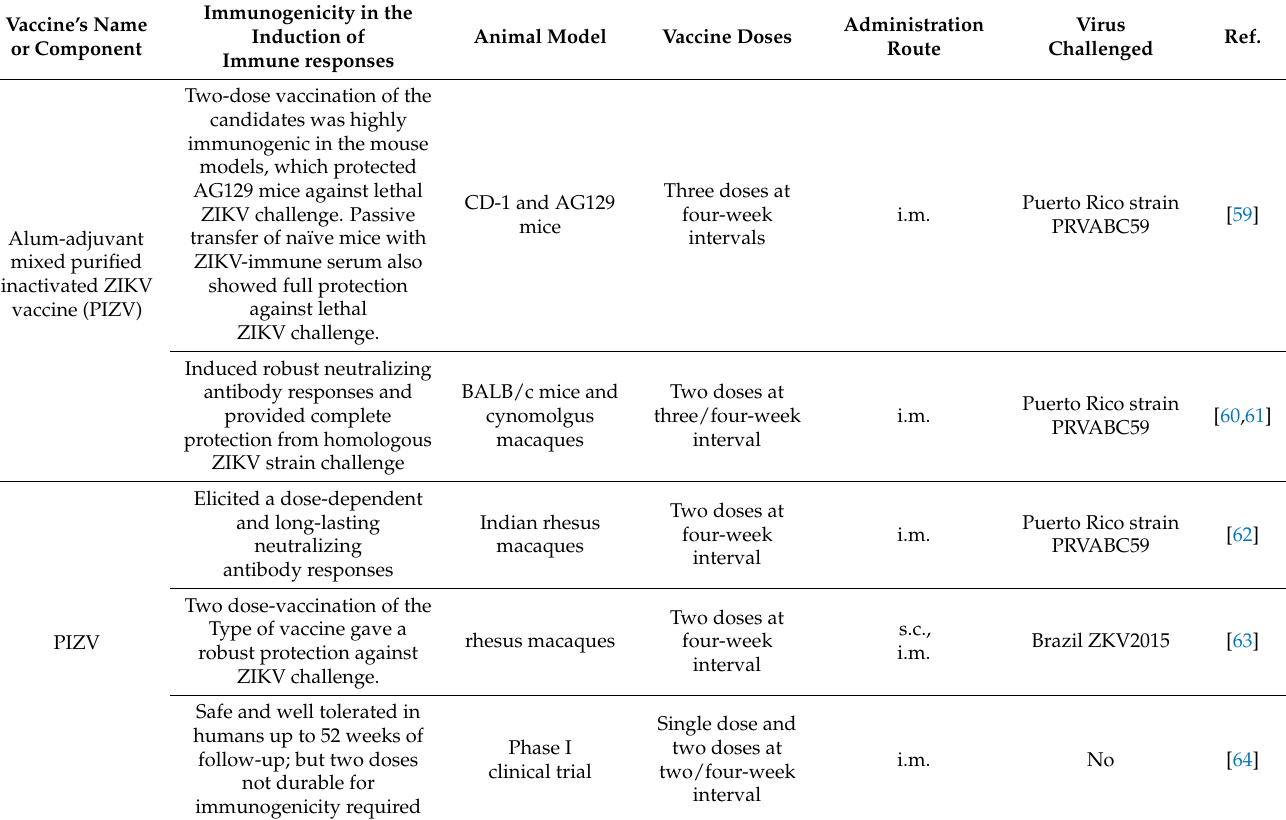
Table 5. Inactivated vaccines against ZIKV